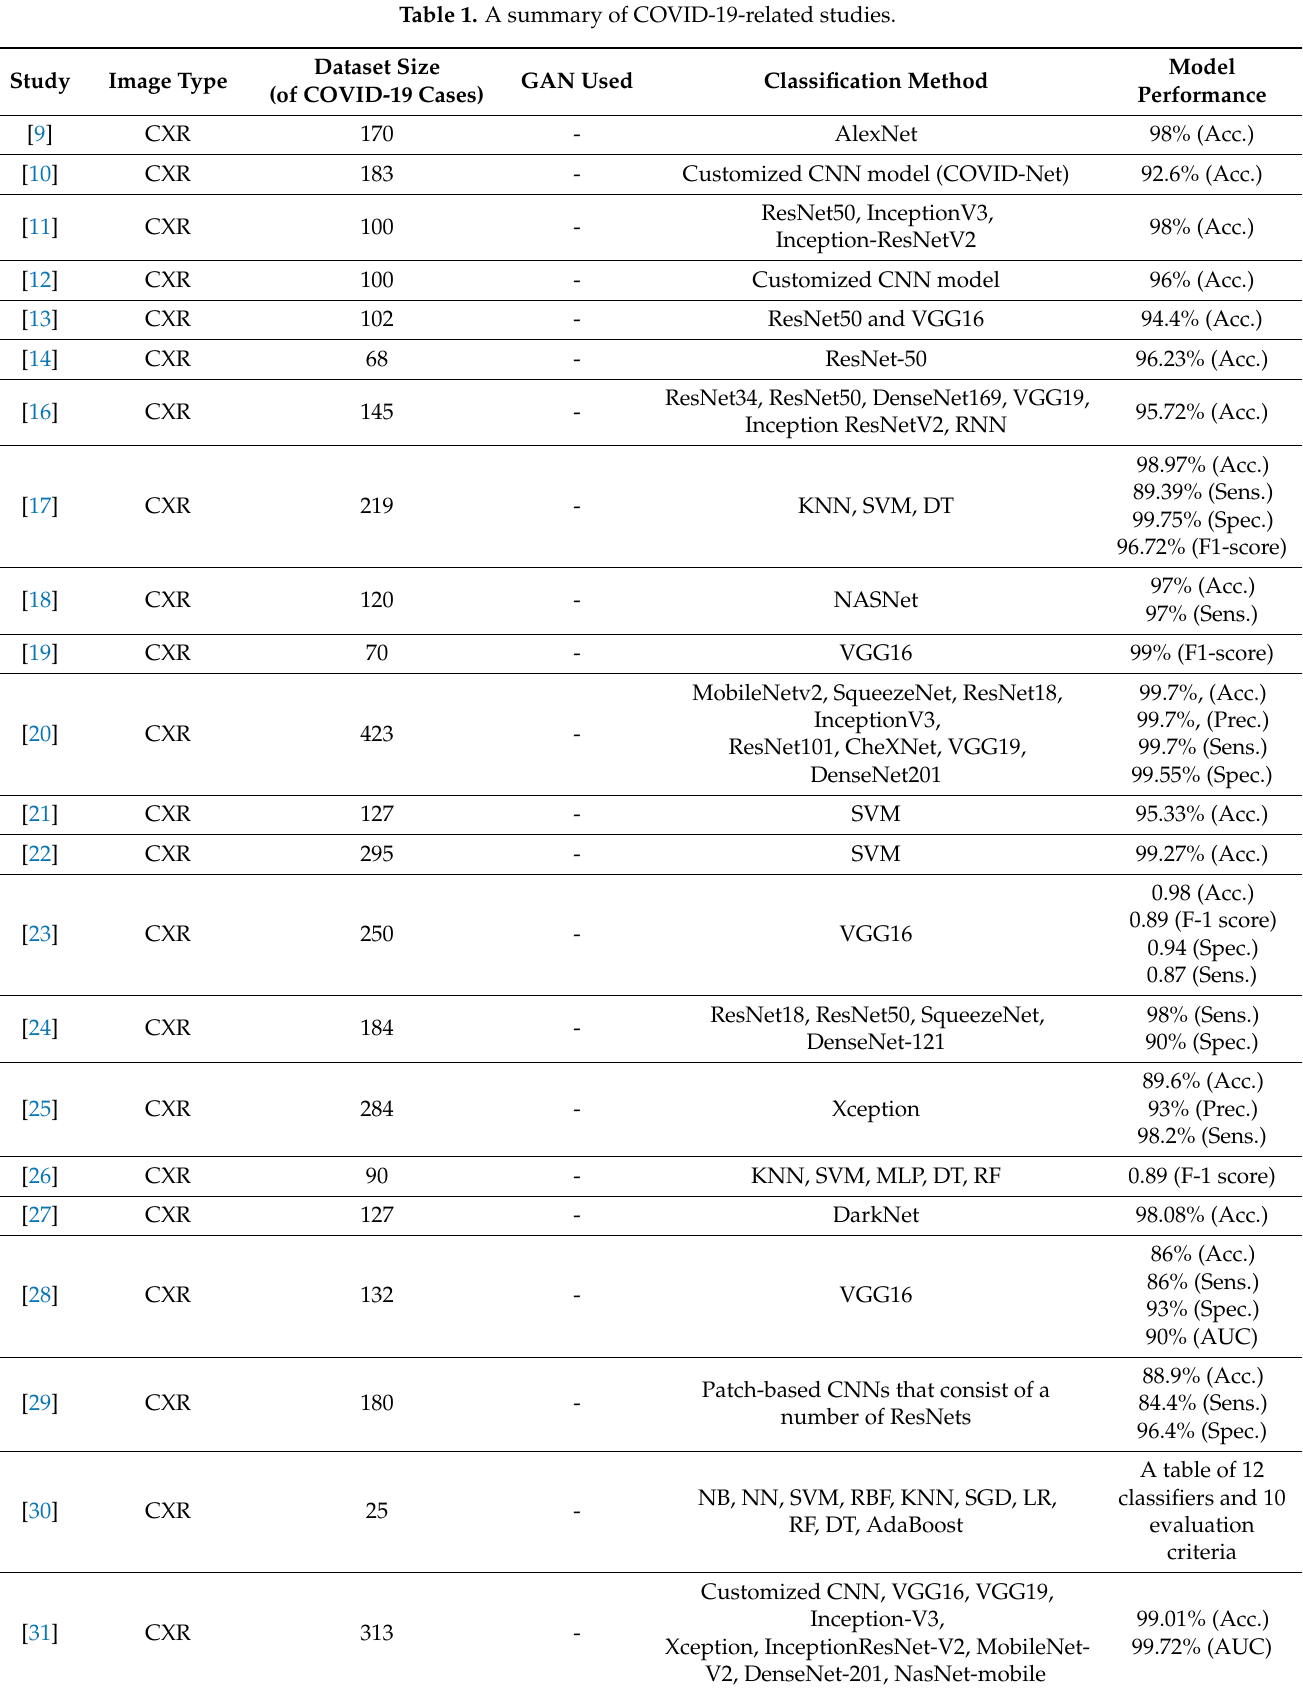
Table 1. A summary of COVID-19-related